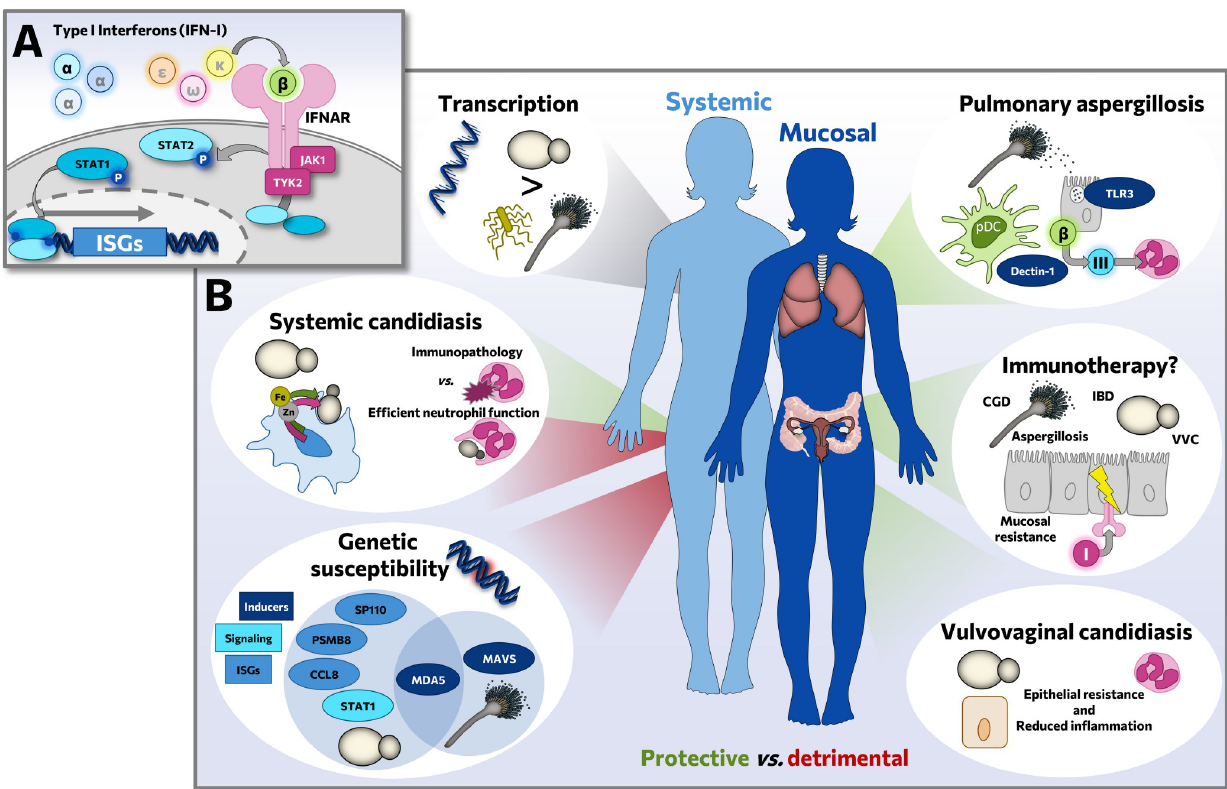
Fig 1. (A) Overview of mechanistic IFN-I signaling, activating ISG expression via route of the IFNAR heterodimer and downstream interaction of the kinases JAK1 and TYK2 with STAT1/2 transcription factors. (B) Overview of how IFN-I steer immune responses in infections caused by Candida species and A . fumigatus . C . albicans causes specific enrichment of IFN-I responses, and genetic variations in the IFN-I pathway are linked to susceptibility to candidiasis and aspergillosis. While remaining controversial in systemic candidiasis, IFN-I are largely found protective on mucosae and during aspergillosis rather a protective role is observed. This renders IFN-I lucrative as potential immunotherapeutics on mucosal surfaces. CCL8, C-C motif chemokine ligand 8/monocyte chemoattractant protein 2; CGD, Chronic granulomatous disease; IBD, inflammatory bowel disease; IFN-I/I, type I interferon; III, type III interferon; IFNAR, IFN- α / β receptor; ISG, interferon-stimulated gene; JAK1, Janus kinase 1; MAVS, mitochondrial antiviral signaling protein; MDA5, melanoma differentiation-associated protein 5/interferon induced with helicase C domain 1; pDC, plasmacytoid dendritic cell; PSMB8, proteasome 20S subunit beta-8; SP110, speckled 110 kD/interferon-induced protein 41; STAT, signal transducer and activator of transcription; TLR, Toll-like receptor; TYK2, tyrosine kinase 2; VVC, vulvovaginal